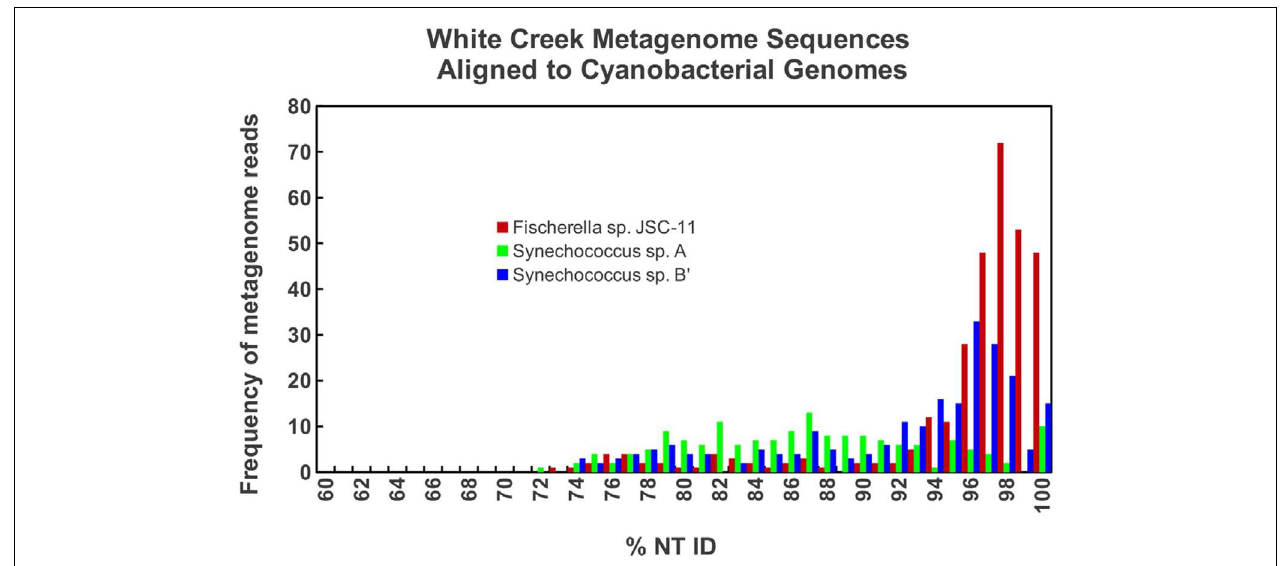
FIGUREA2 | BLASTN recruitment ofWhite Creek (WC_6) metagenome sequence reads to representative cyanobacterial genomes .